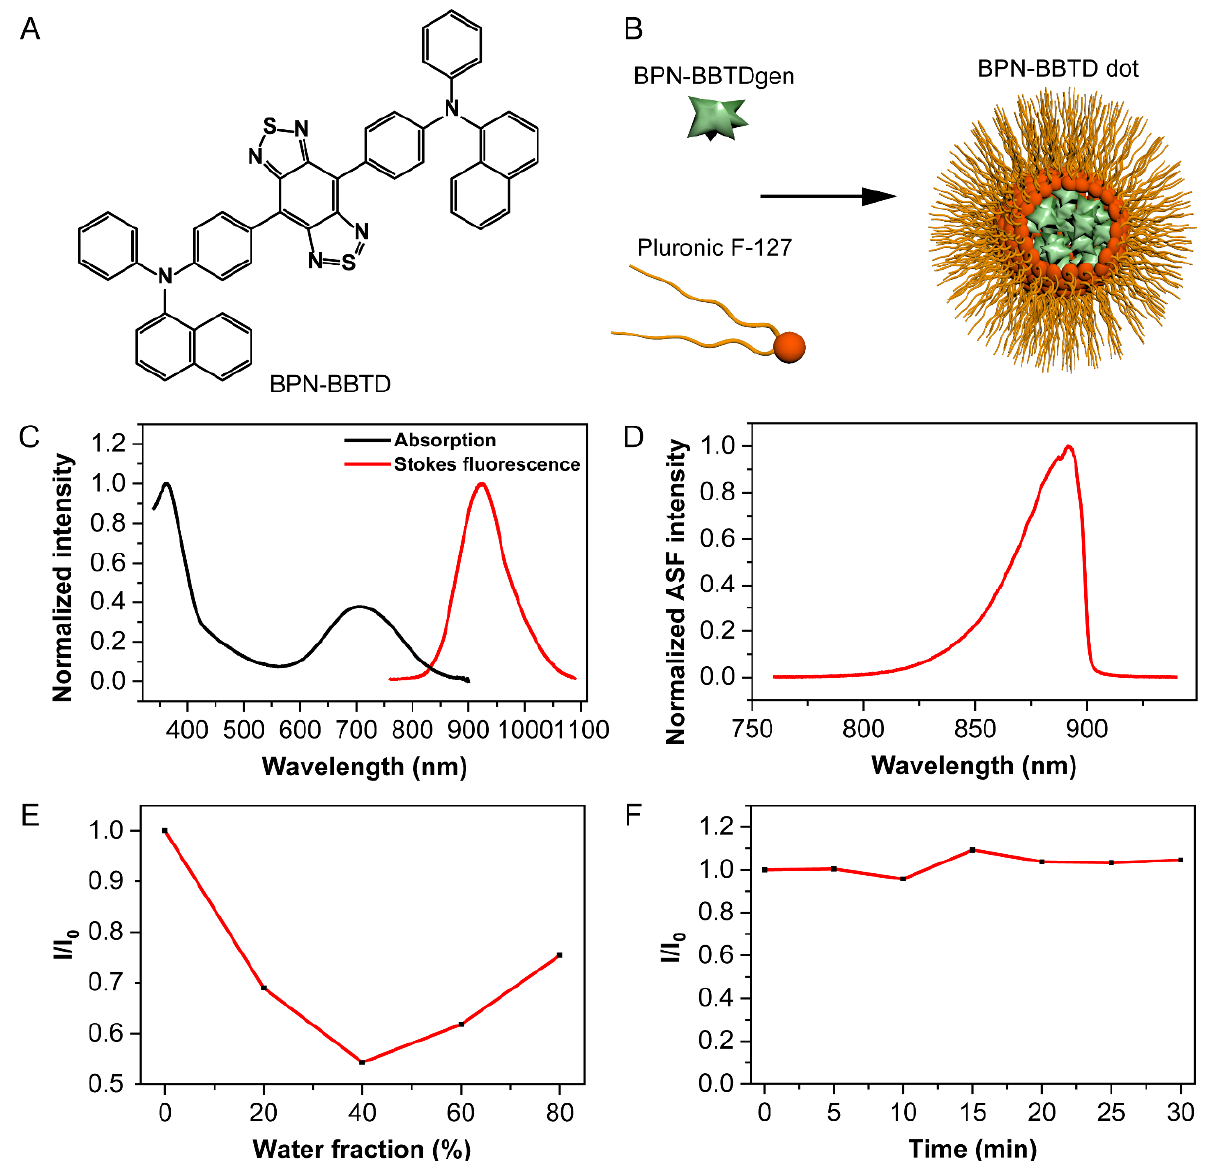
Figure 1. Characterizations of BPN-BBTD. ( A ) The chemical structure of the BPN-BBTD molecule. ( B ) The schematic illustration of the modification of BPN-BBTD dot. ( C ) The normalized absorption and the Stokes fluorescence spectra. The excitation wavelength for Stokes fluorescence is 665 nm. ( D ) The normalized anti-Stokes fluorescence spectrum of BPN-BBTD dots in an aqueous dispersion excited by a 980 nm continuous-wave laser. ( E ) The anti-Stokes fluorescence intensity of BPN-BBTD versus the water fraction in the THF/water mixture. I 0 and I are the anti-Stokes fluorescence intensities of BPN-BBTD molecules in pure THF and THF/water mixtures with specific water fractions, respectively. The concentration of BPN-BBTD is 2 × 10 − 5 M. The excitation wavelength is 980 nm. ( F ) The anti-Stokes fluorescence intensity of BPN-BBTD dots (2 mg/mL) under the continuous laser irradiation (980 nm, ~500 mW/cm 2 ). I 0 and I are the anti-Stokes fluorescence intensities of BPN-BBTD dots under zero irradiation and after a certain time of irradiation, respectively.